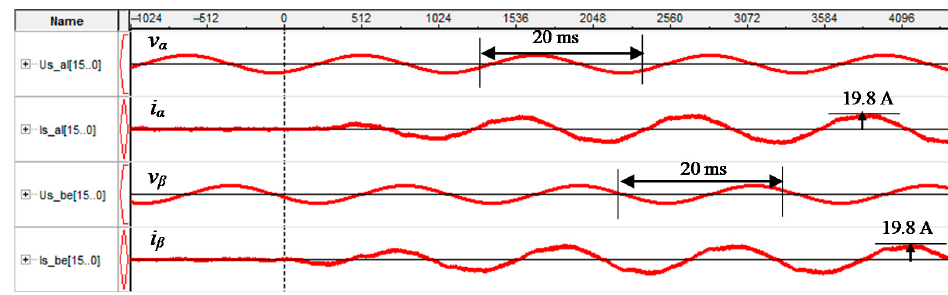
Figure 14. Device startup–change in active and reactive component of the current to 0.7 P N .